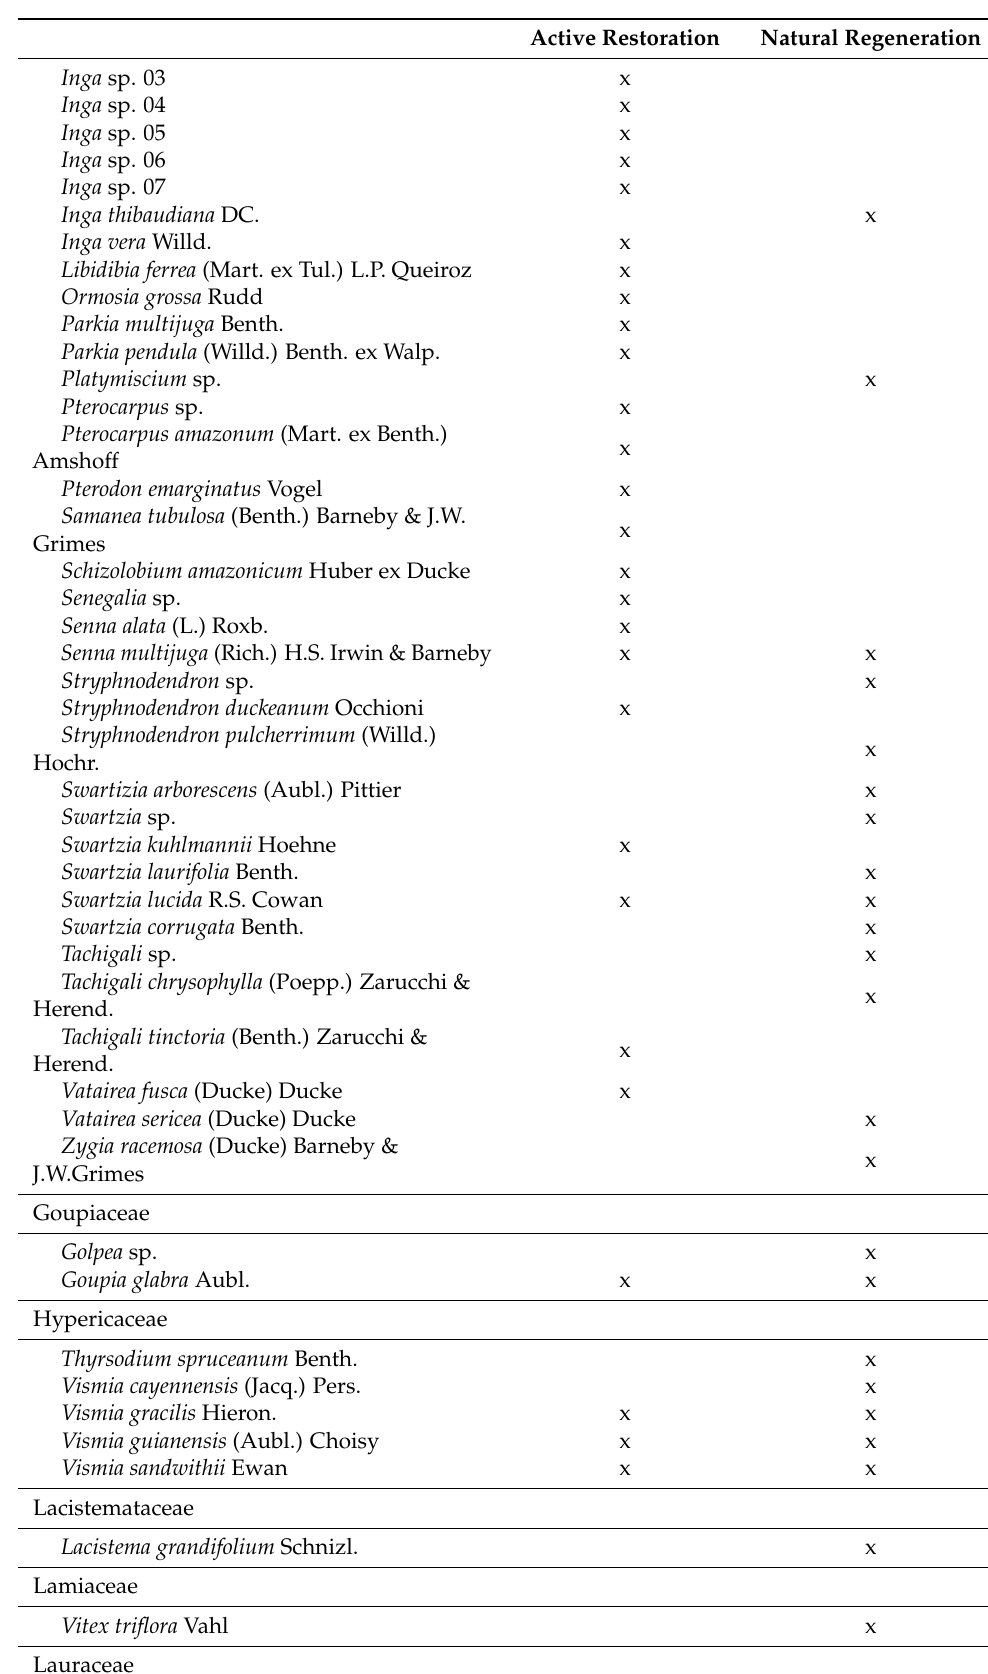
Active Restoration Natural Regeneration